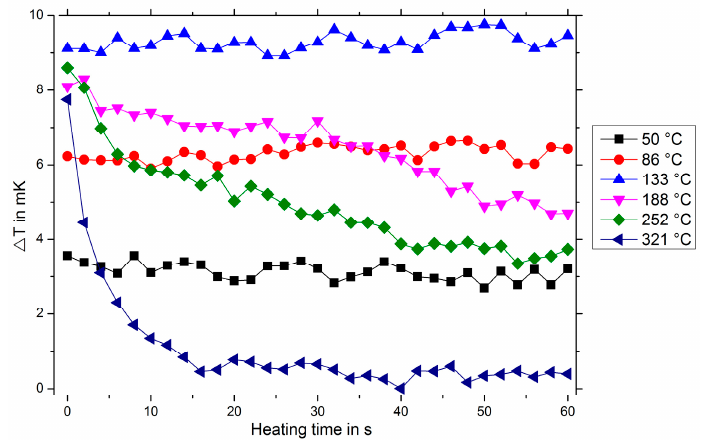
Figure 5. Δ T for different heating temperatures as a function of time. The sensor has been exposed to 1.5 mg/m 3 Hg for 10 min.